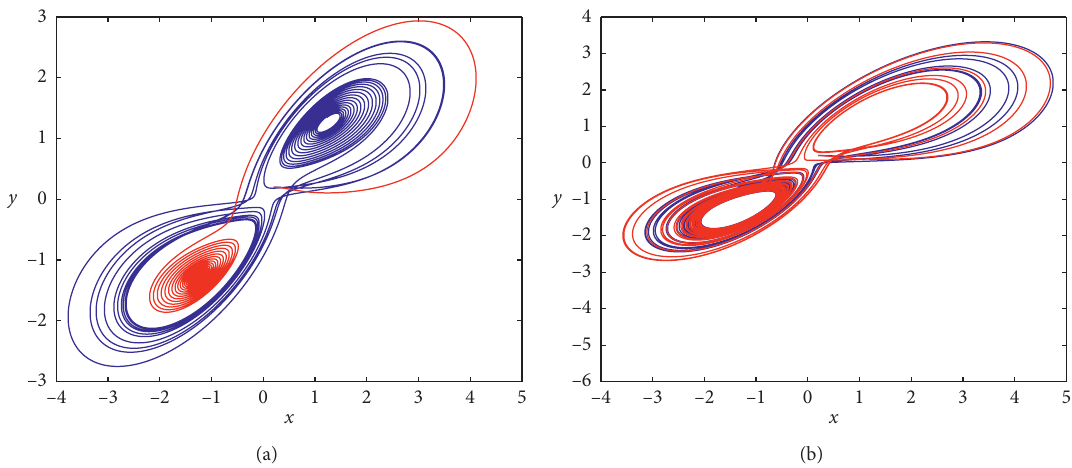
Figure 22: (a) Portrait at a � 0 . 6 in the plane ( x, y ) . (b) Portrait at a � 0 . 6 in the plane ( x, y )